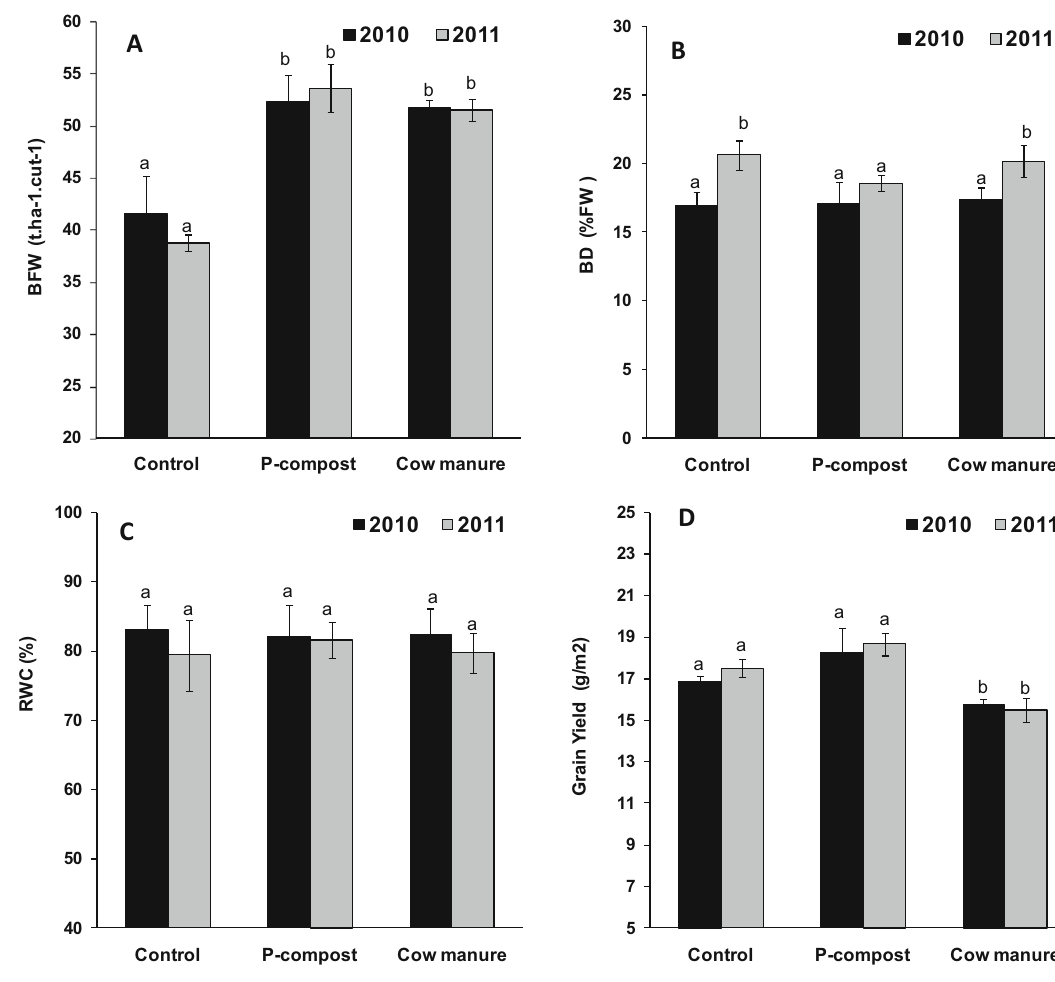
Fig. 1 The effect of date palm compost and cow manure application on fresh matter of aerial parts per harvest—BFW ( a ), dry matter percent ( b ), relative water content ( c ) and grain yield ( c ) in two crop